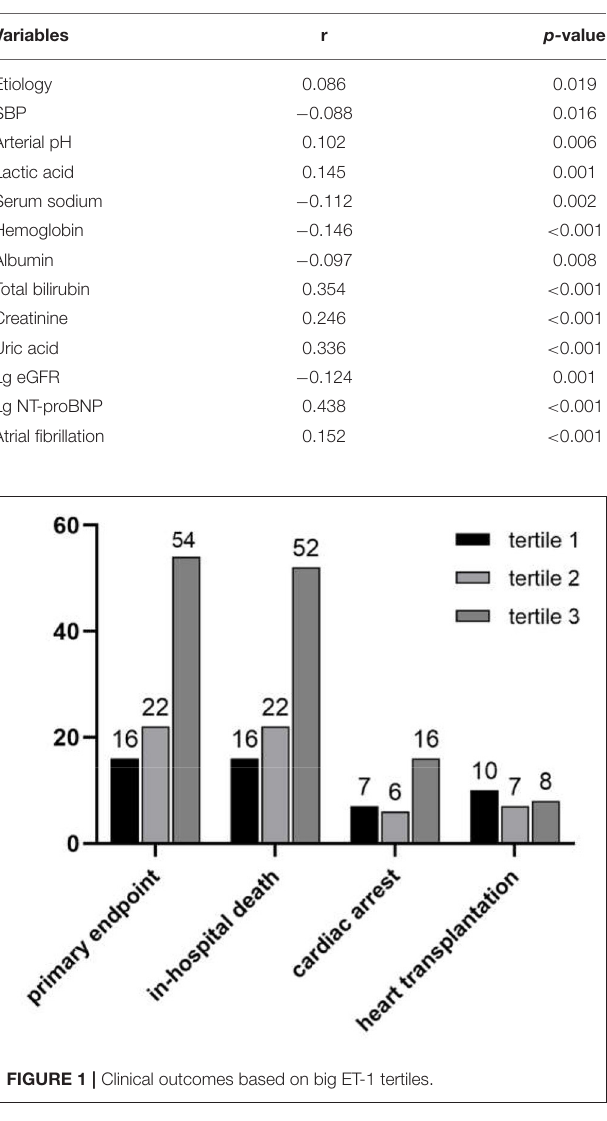
TABLE 2 | Bivariable correlation between big ET-1 and clinical variables.